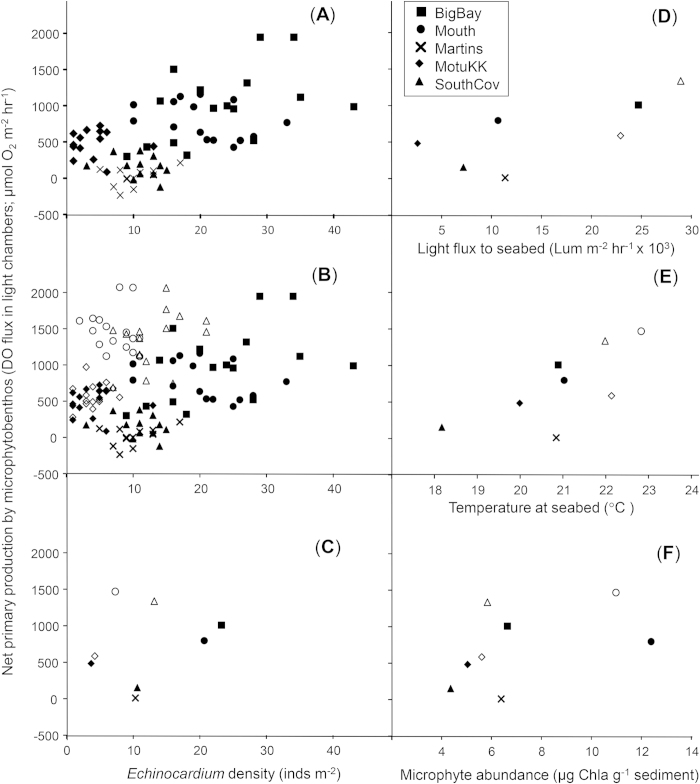
Net Primary Production (NPP) measured in benthic incubation chambers deployed at 5 sites in the Mahurangi Harbour-Kawau Bay study region. (A) The general positive relationship between Echinocardium density and NPP observed during the first summer of sampling; n = 16 replicates from each of 5 sites sampled between Dec 2006 and Feb 2007. (B) Echinocardium vs NPP with all of the data from two consecutive summers of sampling included; open symbols are replicates from the second summer of sampling. (C) Bivariate scatterplot of site averages. The remaining panels show average NPP at a site versus (D) light levels measures at the seabed, (E) the temperature of the bottom water, and (F) the content of Chla in the sediment.